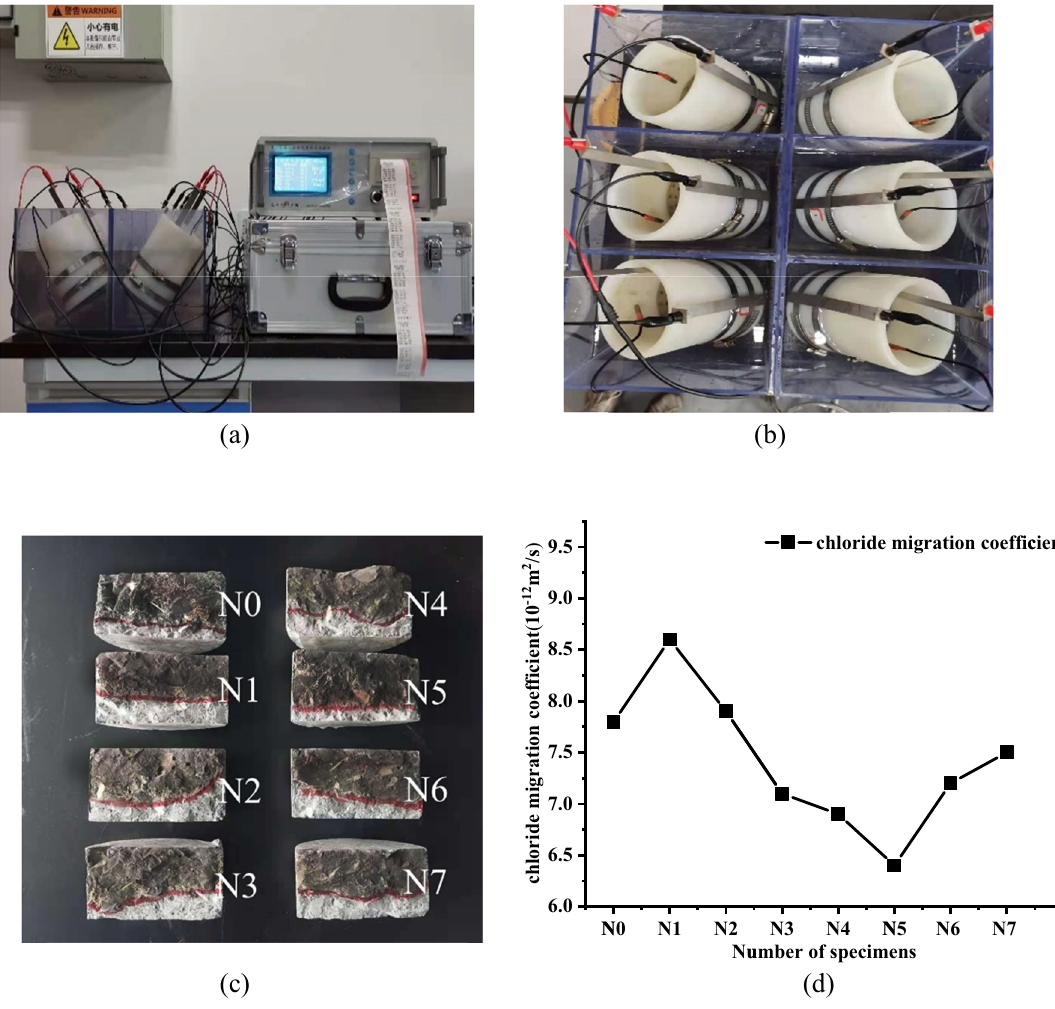
Figure 11: Chloride permeability test. ( a ) Multifunctional concrete durability comprehensive test instrument. ( b ) Chloride